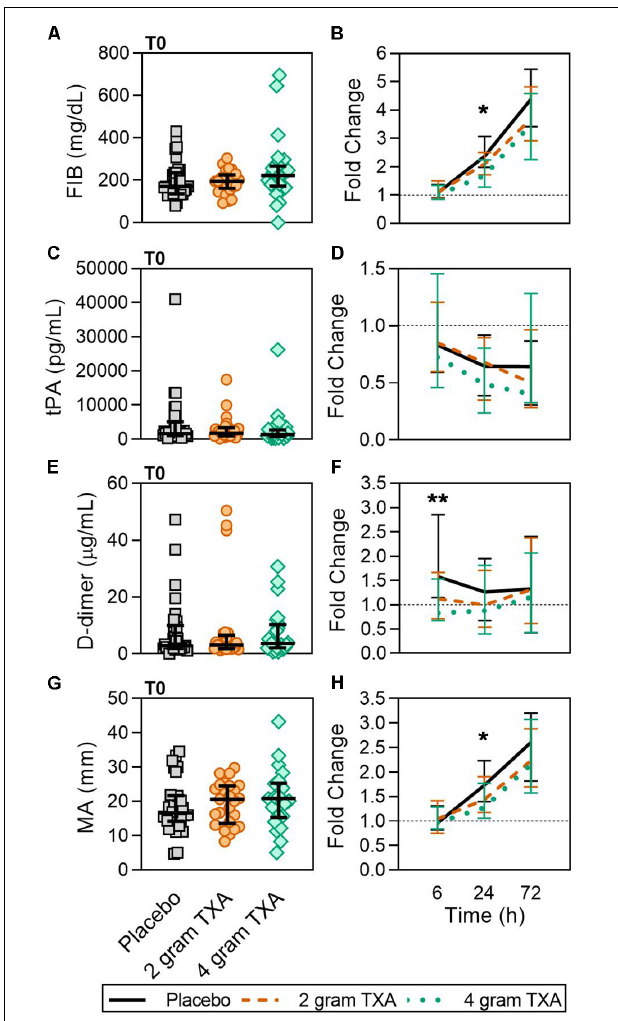
FIGURE 8 | A higher dose of TXA decreases circulating D-dimer levels early after administration. For T0, data are represented as individual points with median + IQR for error bars. For all kinetic data, fold change was calculated as [(frequency/MFI/concentration of a given population/analyte at the given time | | T6,T24,T72| |) ÷ (frequency/MFI/concentration of the same population/analyte at T0)]. Data are displayed as line graphs (fold change, median + IQR). The dashed line placed at y = 1 represents T0, or baseline. Placebo, n = 29; 2 g TXA, n = 24; 4 g TXA, n = 25. Statistical differences between the 4 g TXA and placebo groups at each given time point, as calculated via Kruskal-Wallis, are noted as follows: p < 0.01, **; p < 0.05, *; p > 0.05, not significant and not denoted on the graphical representation. (A) Fibrinogen (FIB, mg/dL) levels at T0 in all three treatment groups (placebo, n = 31; 2 g TXA, n = 25; 4 g TXA, n = 25). (B) Fold change in FIB levels over the study period of 72 h (placebo, n = 17; 2 g TXA, n = 13; 4 g TXA, n = 10). (C) Tissue plasminogen activator (tPA, pg/mL) levels at T0 in all three treatment groups (placebo, n = 31; 2 g TXA, n = 25; 4 g TXA, n = 25). (D) Fold change in tPA levels over the study period of 72 h (placebo, n = 28; 2 g TXA, n = 24; 4 g TXA, n = 20). (E) D-dimer (D-Di, µ g/mL) levels at T0 in all